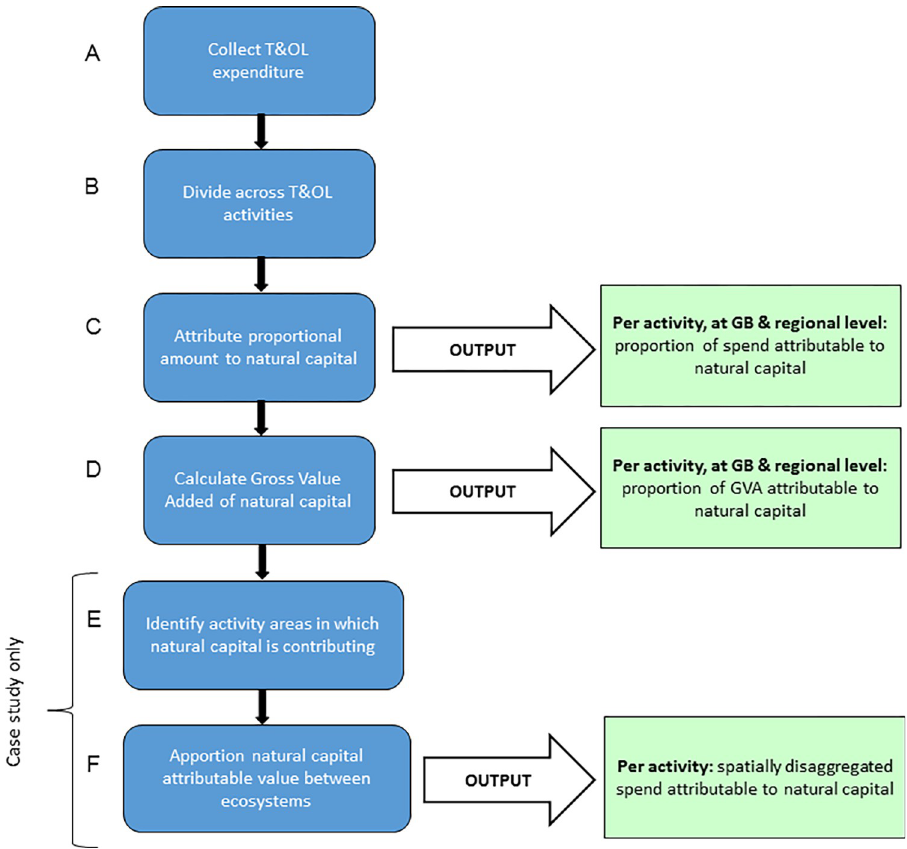
Fig 2. Flow diagram of method. Stages for calculating natural capital contribution to T&OL